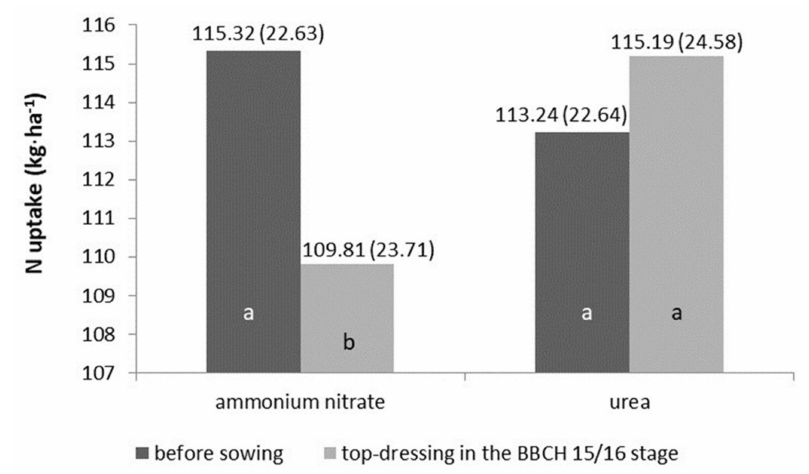
Figure 2. Mean values and standard deviations (in brackets) of N uptake (kg · ha − 1 ) in successive years for the combinations of two types of nitrogen fertilizer (B) and two dates of nitrogen application (C). a, b—homogeneous groups ( α = 0.01).